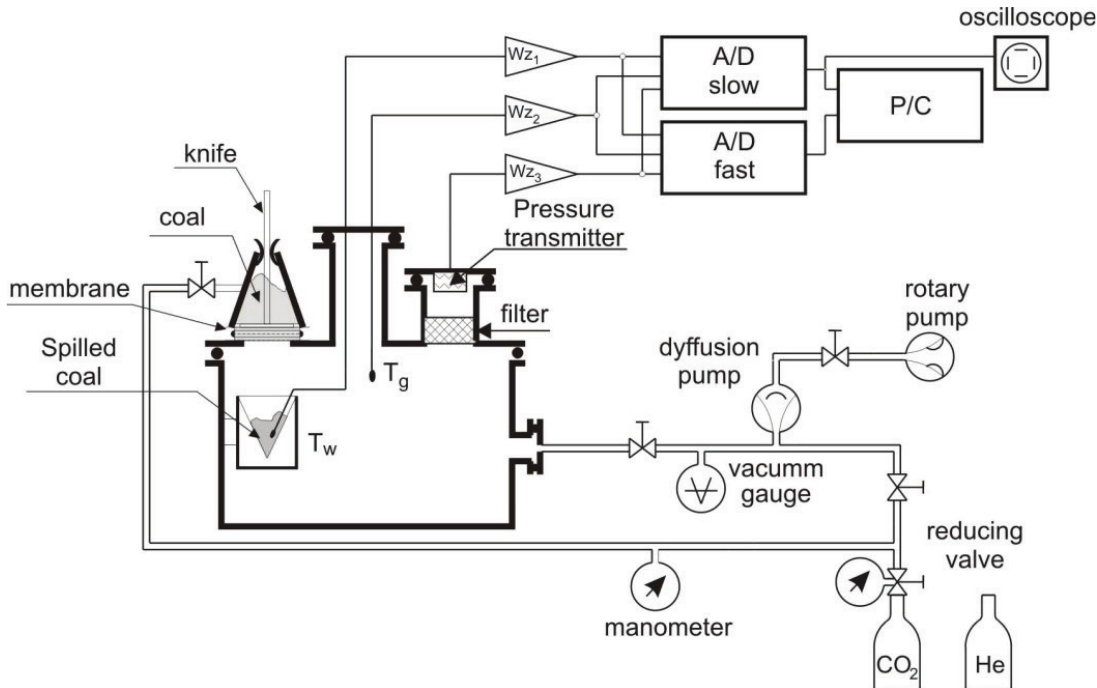
Figure 3: Scheme of the setup for testing the gas filtration coefficient in coal